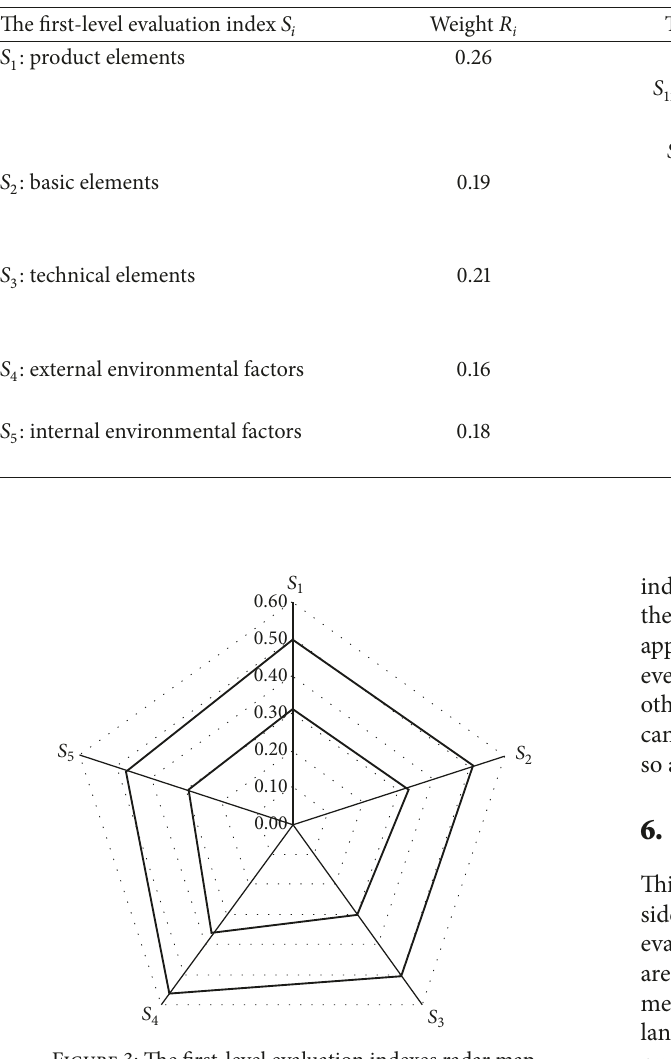
Figure 3: The first-level evaluation indexes radar